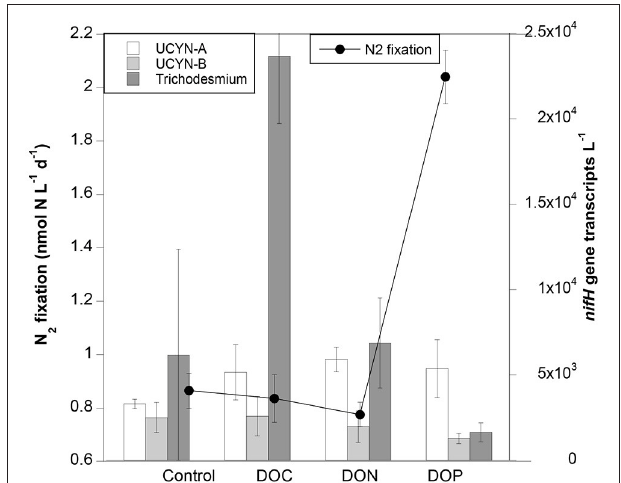
FIGURE 3 | N 2 fixation rates (line) and nifH gene expression ( nifH transcripts L − 1 ; bars) in control, DOC, DON, and DOP treatments performed at Station 2. Error bars indicate the standard deviation of the